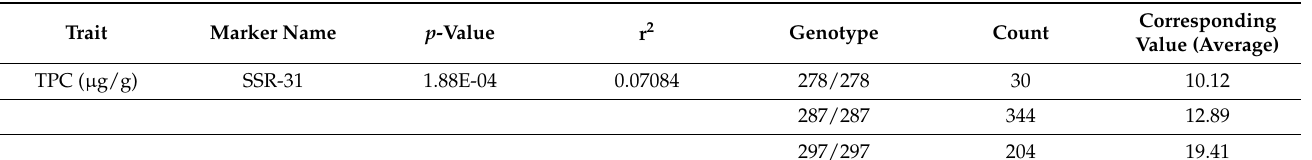
Table 5. Association analysis results for SSR markers: TPC and SOD activity.